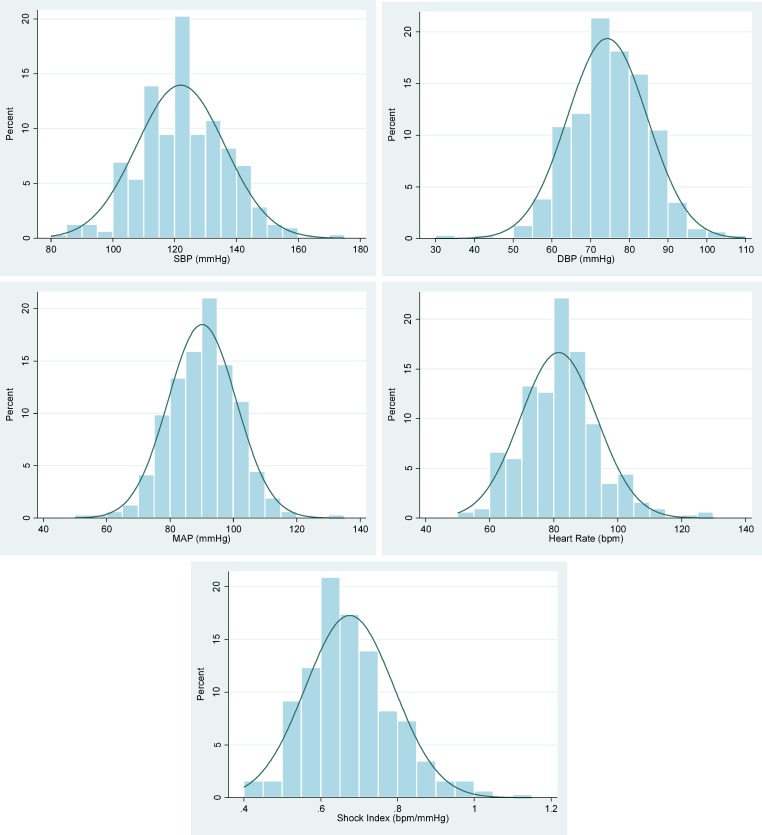
Histograms of distribution of BP, MAP, HR and SI values (with superimposed normal distribution curves).SBP: systolic blood pressure, DBP: diastolic blood pressure, MAP: mean arterial pressure, HR: heart rate, SI: shock index.